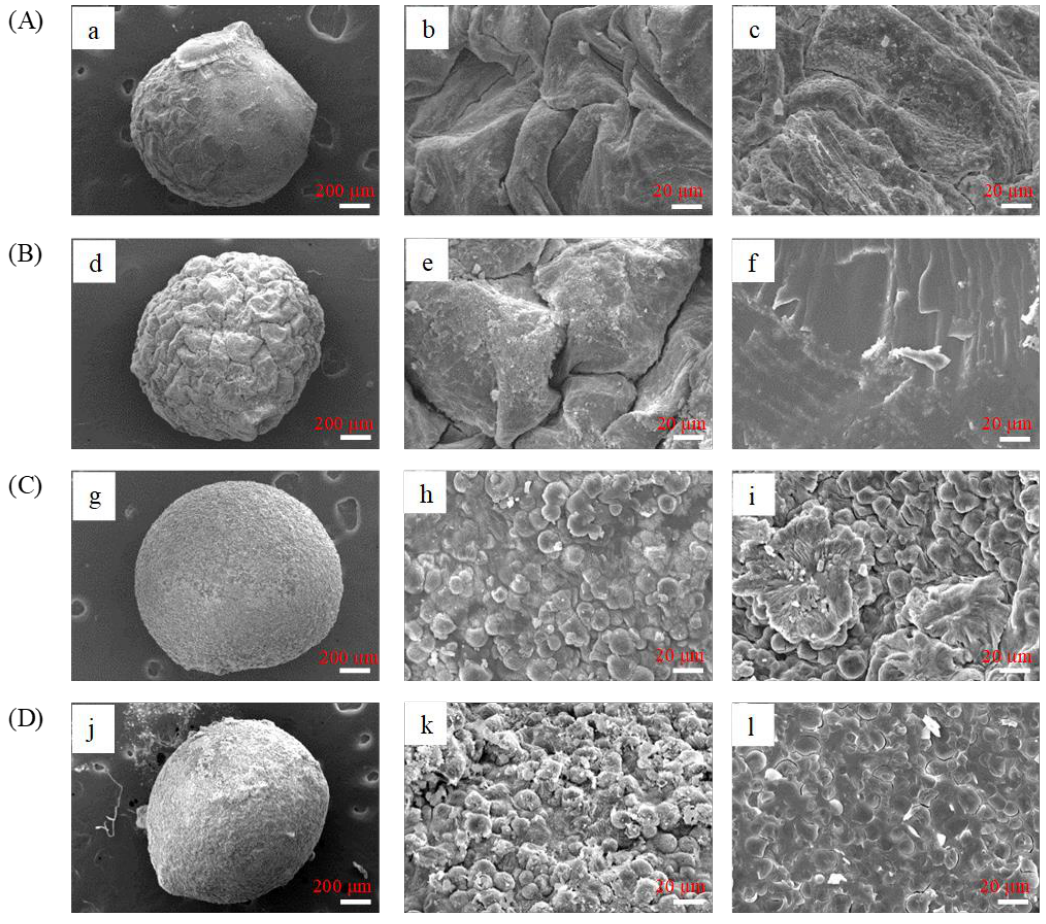
Figure 2. SEM images of ( A ) PHBs-DI, ( B ) PHBs-pH = 5, ( C ) s-PHBs-DI, and ( D ) s-PHBs-pH = 5 for whole bead ( a , d , g , j ), outer surface ( b , e , h , k ), and cross-section inner surface ( c , f , i , l ), respectively.